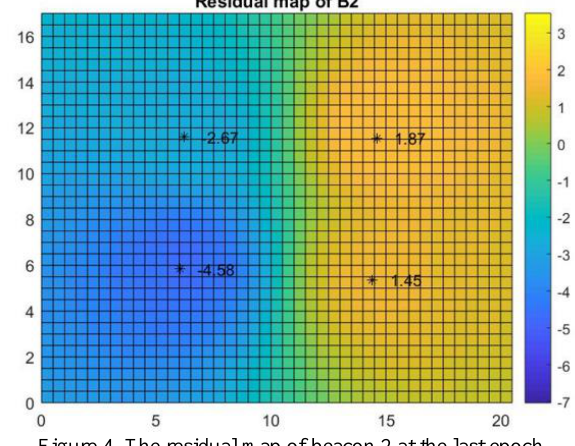
Figure 4. The residual map of beacon 2 at the last epoch 2.3 Pedestrian Dead Reckoning (PDR)